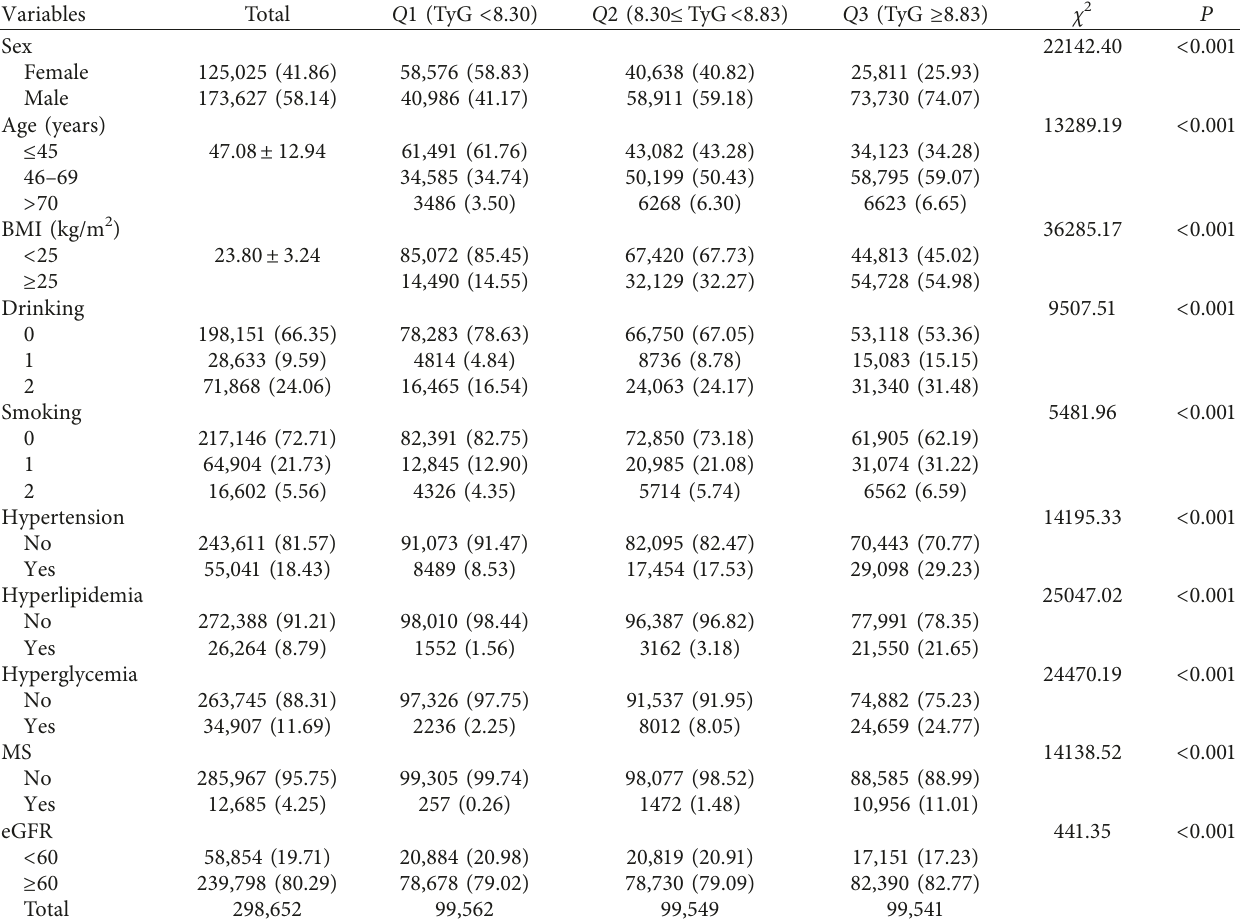
Table 1: Comparison of the demographic characteristics and biochemical indices among the TyG-index subgroups.